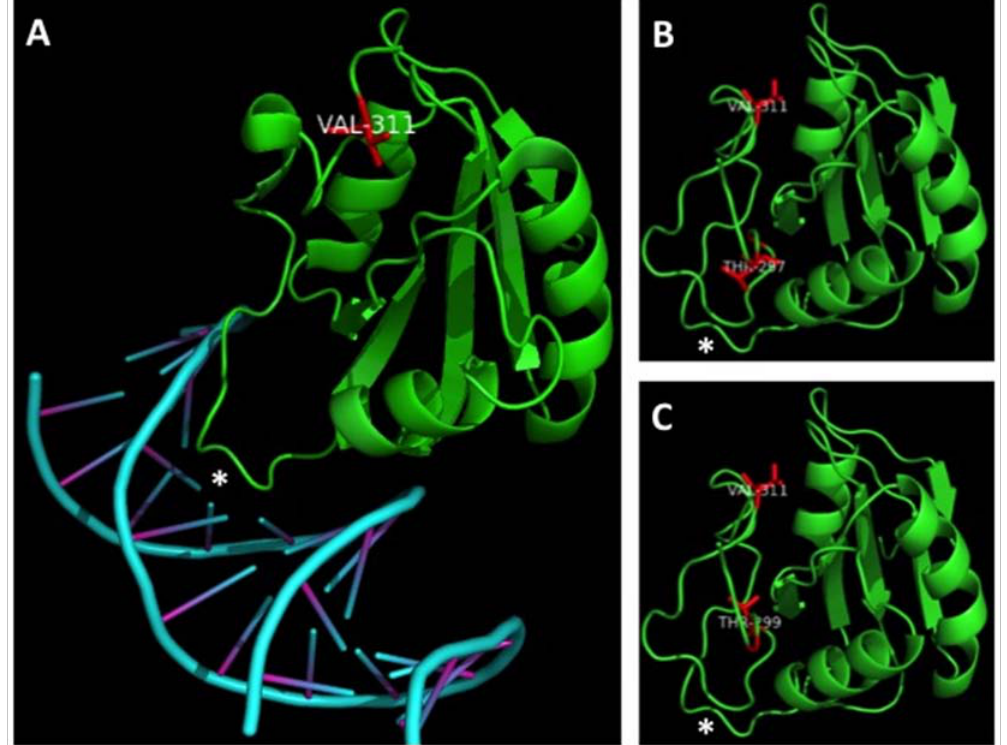
Figure 2. Modeling MCPyV LT’s interaction with DNA. ( A ) Phyre2 and PyMOL